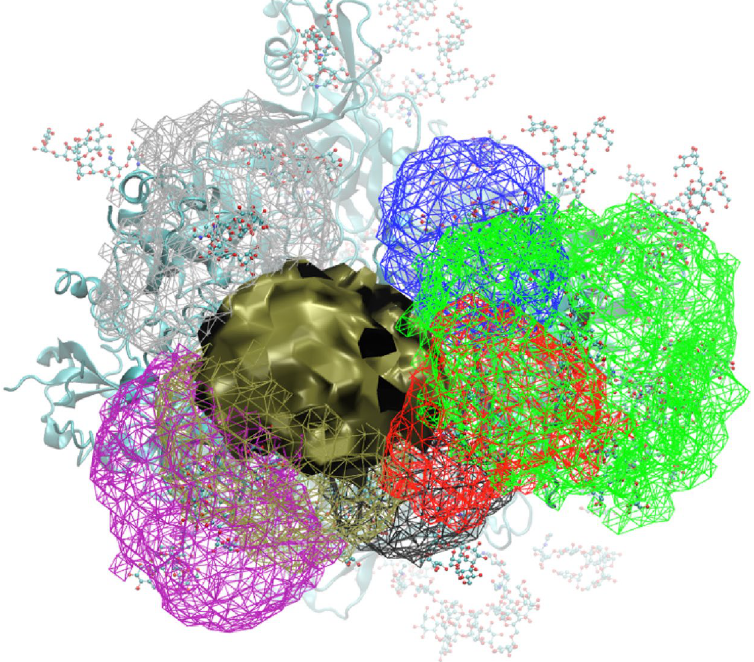
Figure 3. Cartesian volume representations of the range of sampling of all the glycans that interact with M1- g88 (tan solid surface). The volumes for the glycans interacting with M1-g88 are shown in wire representation using the color scheme as follows: M1-g234 (black), M1-g355 (red), M1-g406 (green), M1-g448 (blue), M1- g618 (purple), M1-g625 (tan) and M2-g611 (silver). Contour levels are 10 − 6 with the sum of the 1 Å 3 voxels normalized to 1. The protein is shown in cyan new cartoon representation and all glycans are in atom-colored CPK